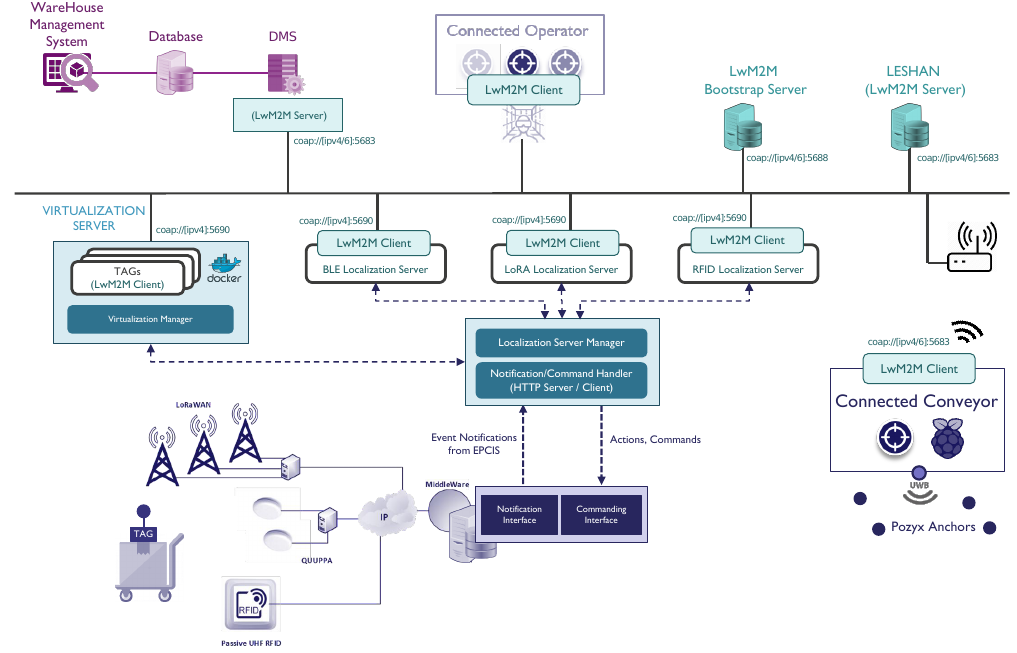
Figure 8. The system implementation for the target use